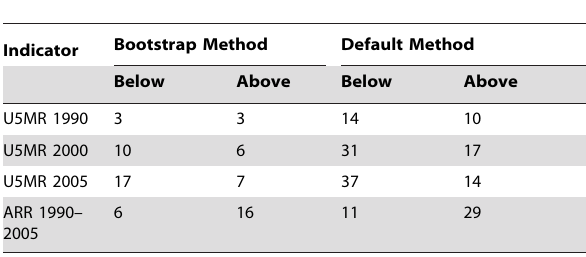
Table 4. Validation results for the bootstrap method and the default method for high mortality countries based on the 2011